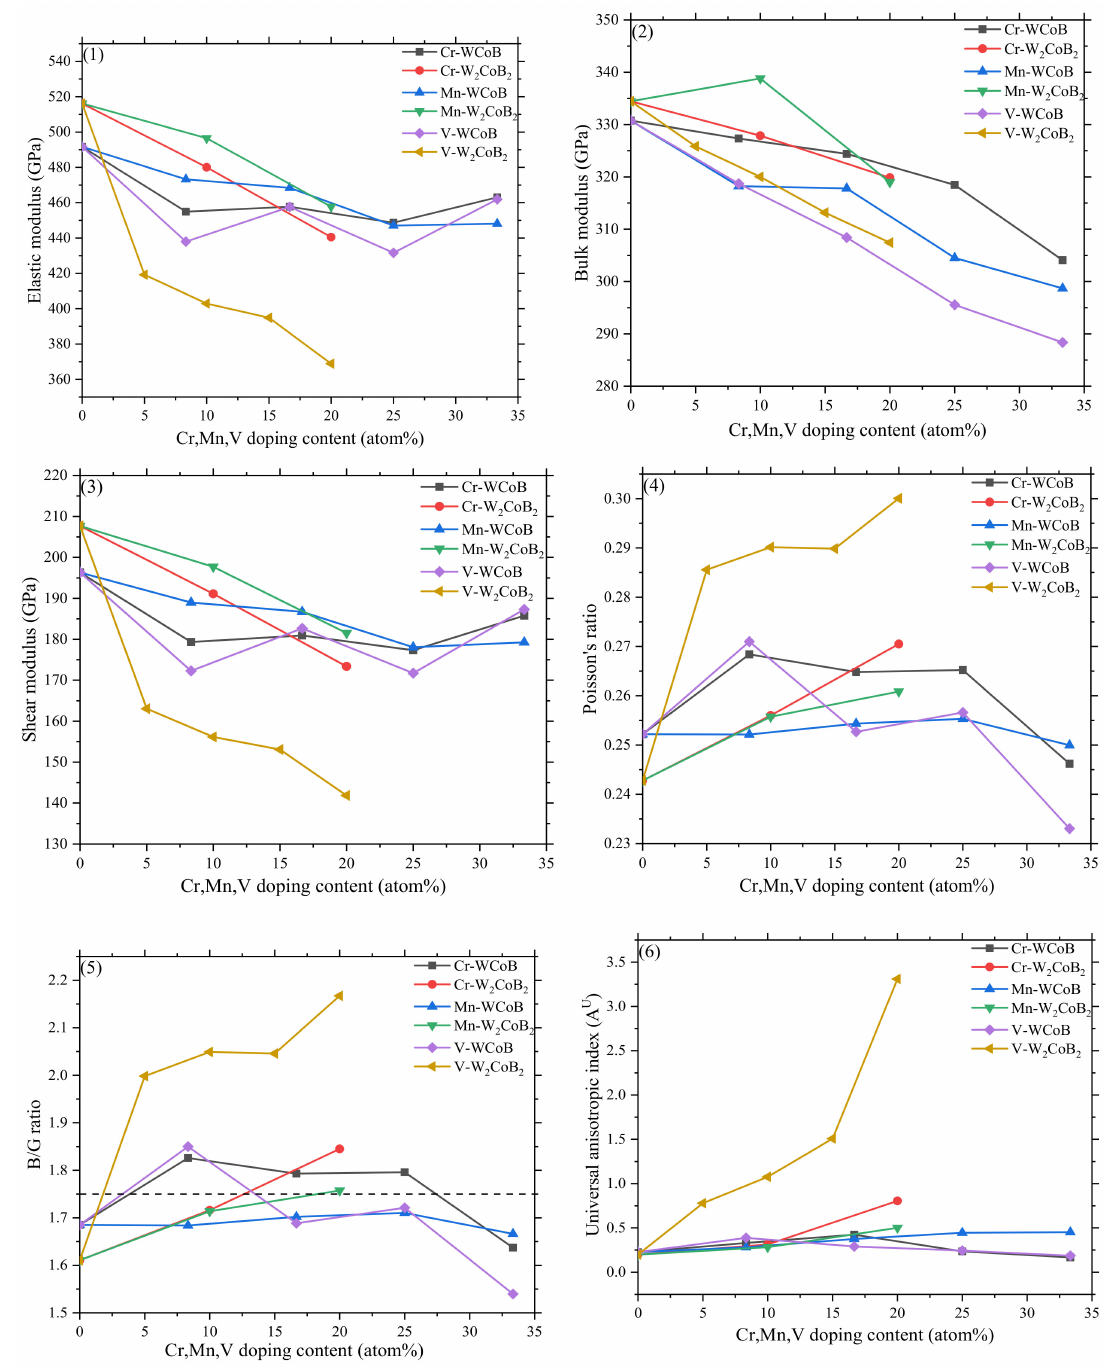
Figure 2. Calculated values of ( 1 ) Elastic modulus E (GPa); ( 2 ) Bulk modulus B (GPa); ( 3 ) Shear modulus G (GPa); ( 4 ) Poisson’s ratio γ ; ( 5 ) B/G ratio; and ( 6 ) universal anisotropic index (A U ) of W 4 Co 4 − x (Cr, Mn, V) x B 4 and W 8 Co 4 − x (Cr, Mn, V) x B 8 ( x = 0, 1, 2, 3,